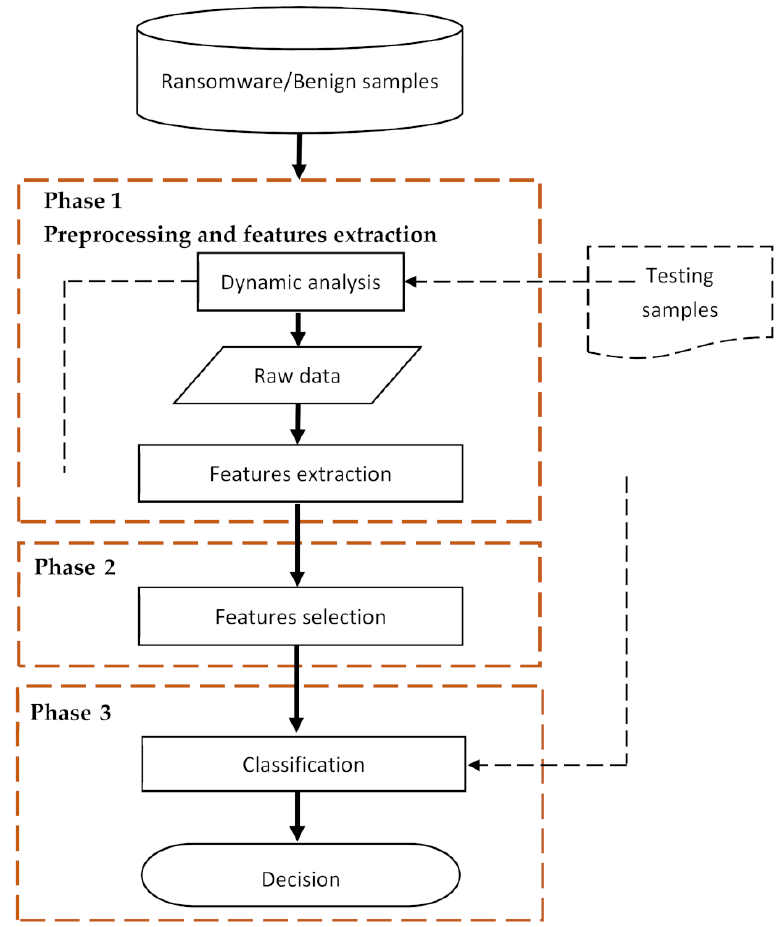
Figure 1. Generic design of crypto ransomware early detection